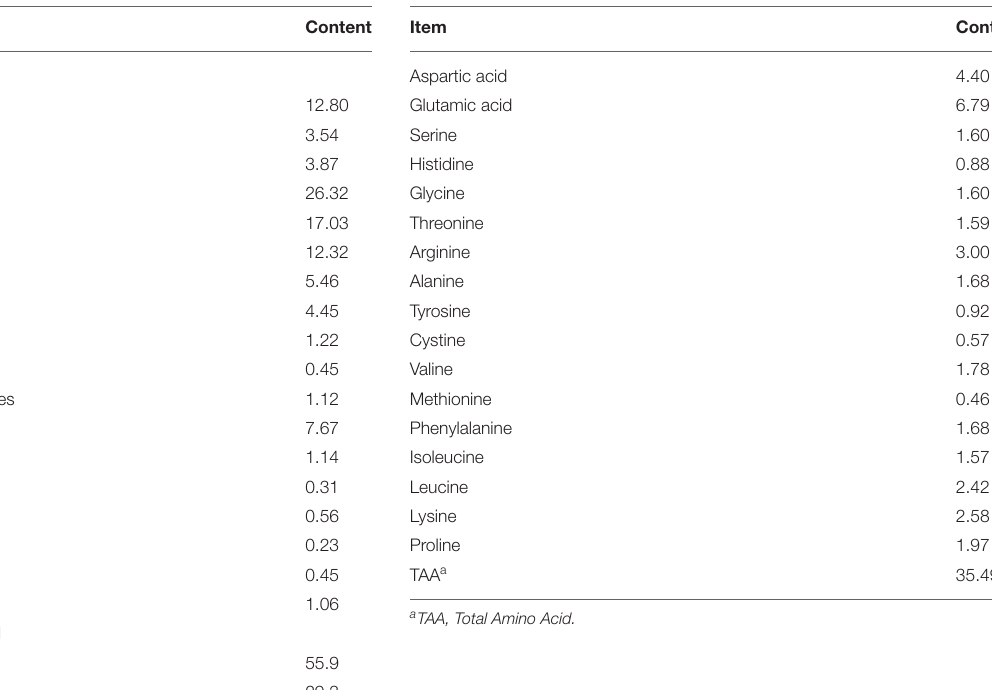
TABLE 2 | The composition and content of amino acids in soybean peptides (dry matter basis,